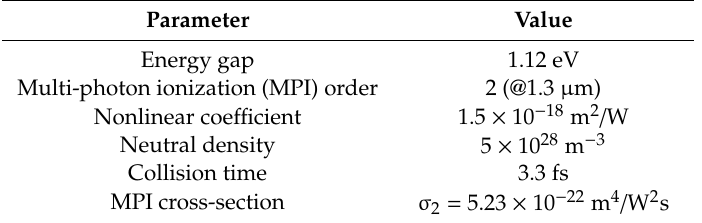
Table 1. Silicon parameters used for unidirectional pulse propagation equation (UPPE)